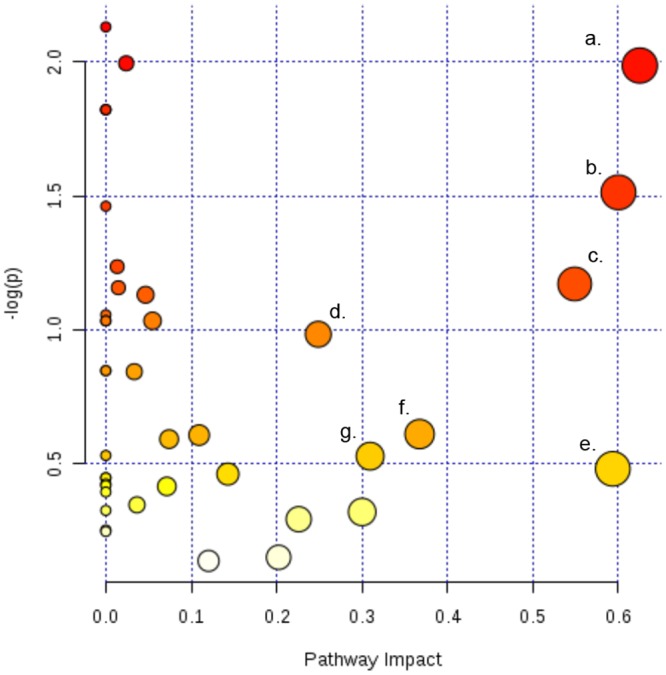
Putative metabolic pathways associated with the wound environment of chronic pressure ulcers.Metabolome summary of pathway analysis. Mapping of the relative concentration of metabolites to the metabolome indicates impact contribution of metabolic pathways. Node color indicates significance based on p-value and node size indicates significance of pathway impact. Significantly impacted pathways include (a) inositol phosphate metabolism, (b) glyoxylate and dicarboxylate metabolism, (c) alanine, aspartate, and glutamate metabolism, (d) arginine and proline metabolism, (e) glycine, serine, and threonine metabolism, (f) pyruvate metabolism, and (g) citric acid cycle (TCA). The metabolic pathways are arranged according to the scores from the enrichment analysis (Fig 4) (Y-axis) and from the topology analysis (X-axis).